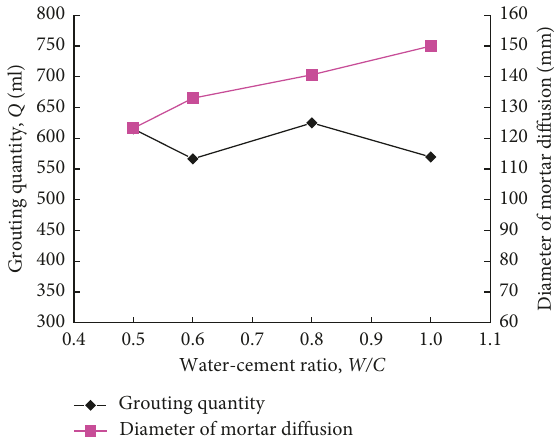
Figure 15: Characteristics of slurry diffusion ( P � 0.3 MPa, k 1 � 0.11cm/s).